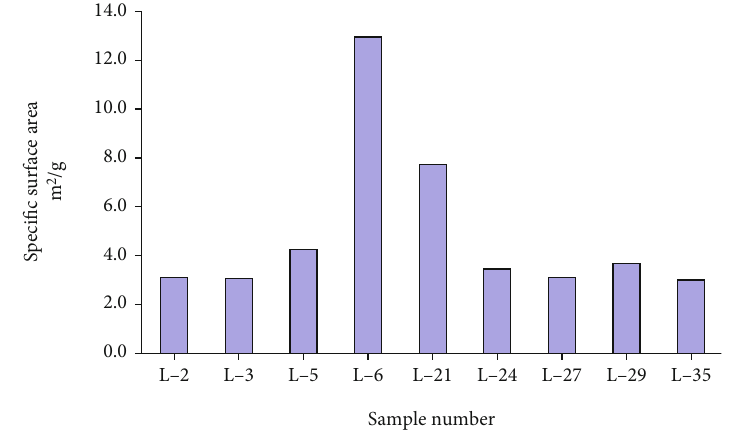
Figure 5: Stratigraphical distribution of the surface area of the shale